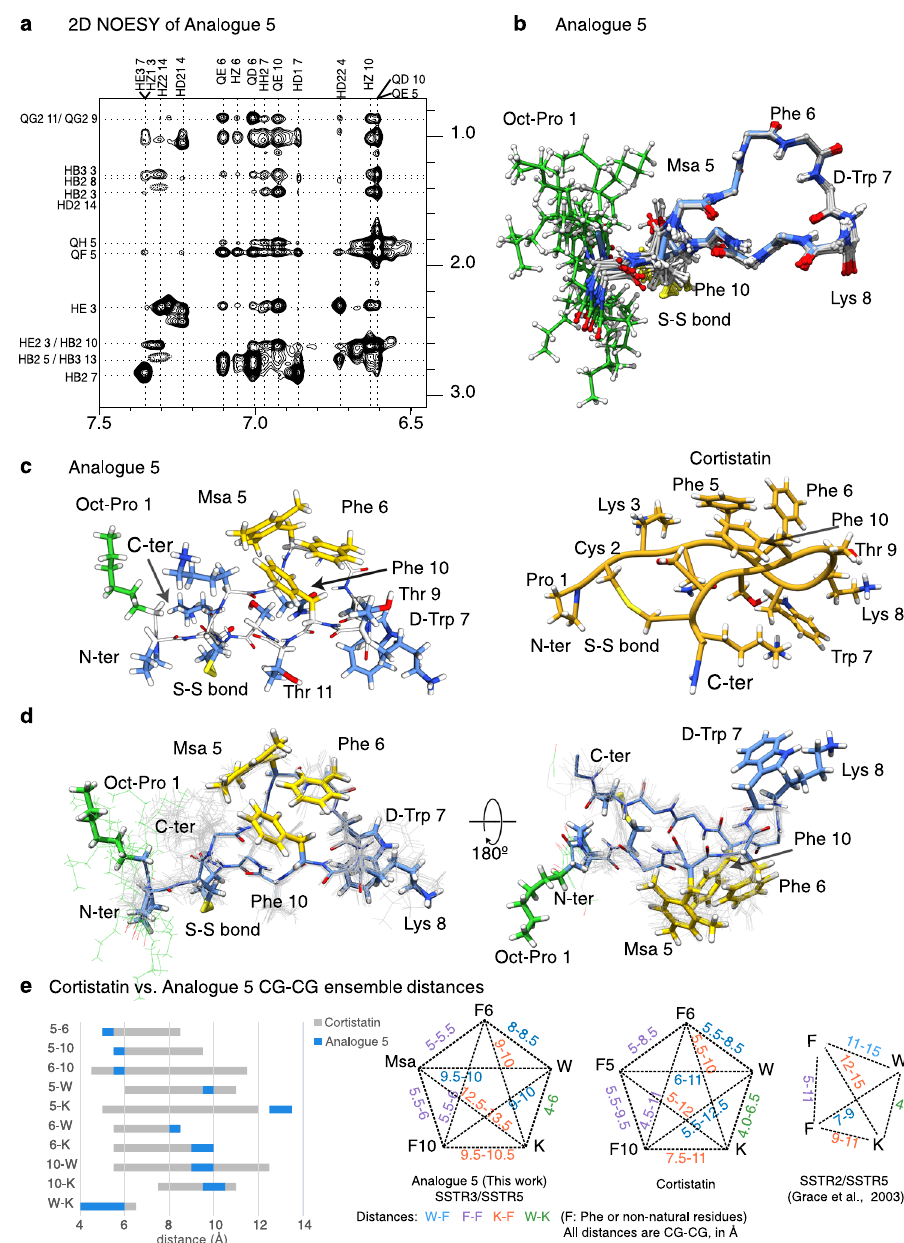
Fig. 7 NMR conformers of analogue 5. NMR restraints and ensemble of conformers corresponding to A 5 . a Side-chain amide region of the analogue 5 ( 1 H-NOESY experiment), with peak assignments. Amide/proton alpha (left) and amide/aromatic (right) regions of the analogue 5 ( 1 H-NOESY experiment), with peak assignments are shown as Supplementary Fig. 7a. 1D set of dilution experiments are included as Supplementary Fig. 7b. b Backbone superposition of the 15 lowest-energy calculated conformers. c Analogue 5 , lowest energy conformer. Side chains are depicted as sticks. The residues de fi ning the aromatic cluster are shown in yellow, the octanoyl moiety is highlighted in green whereas the remaining residues are shown in blue. The peptide backbone is shown in white. On the right, the equivalent Cortistatin conformer for comparison (shown in Fig. 1b). d Side chain and backbone distribution for the ensemble of the 15 best conformers shown as two orientations. Some residues are labelled. e Comparison of the pharmacophore region of analogue 5 to that of Cortistatin conformations represented in Fig. 1b. The comparison includes the distances between C-gamma atoms of the fi ve residues considered to de fi ne the pharmacophore. The backbone and Chi1 comparison of these six molecules are provided as Supplementary Fig. 7c. Distances are represented as ranges to include the distance dispersion in the ensemble of